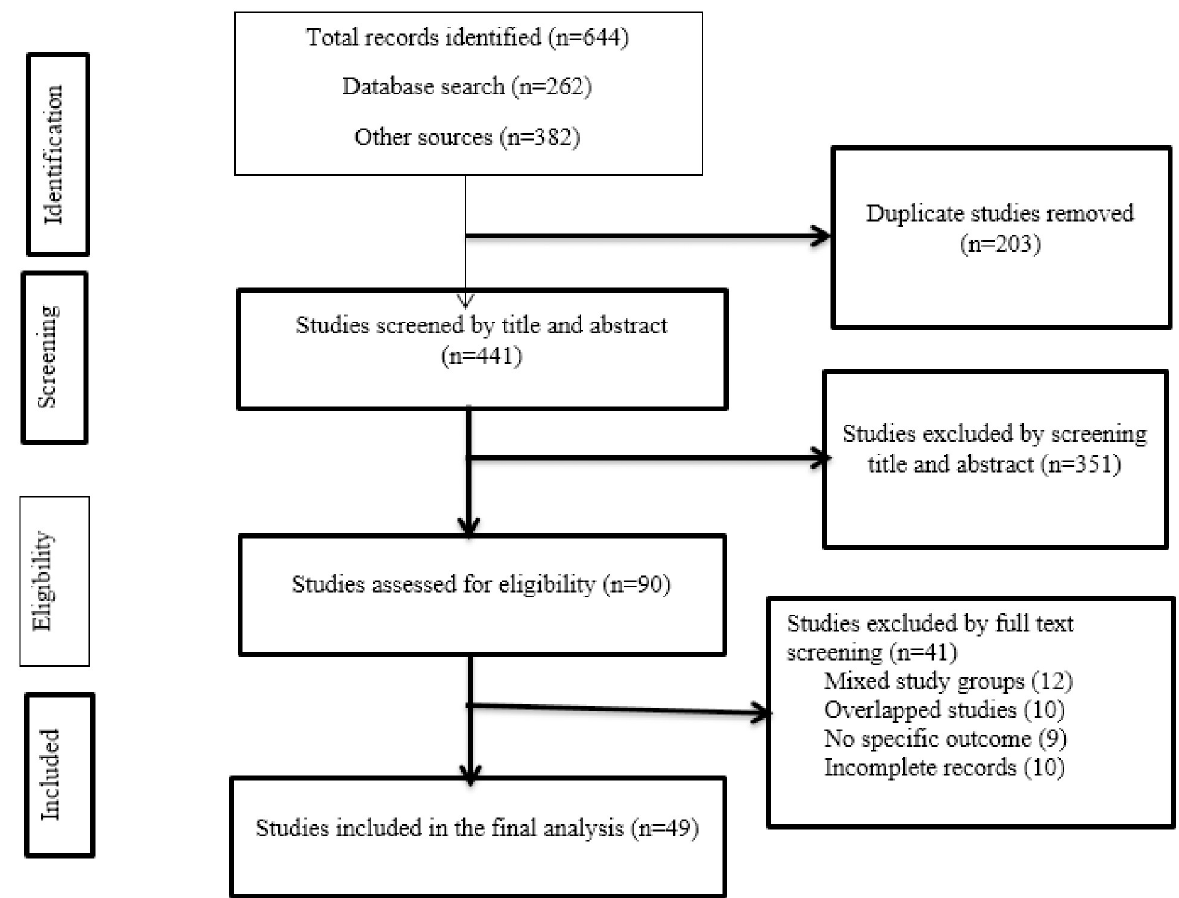
Fig 1. Flowchart diagram describing a selection of studies for the systematic review and meta-analysis on the predictors of mortality in patients with drug-resistant tuberculosis.